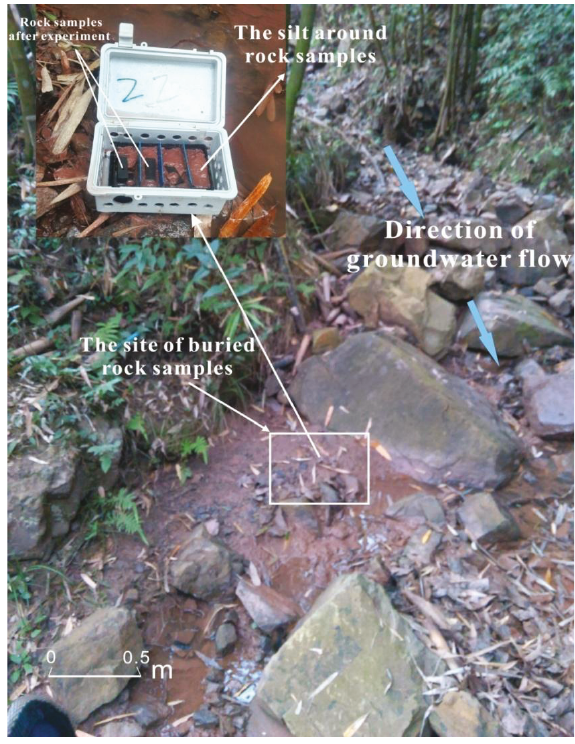
Figure 20: The site of the fi eld experiment.